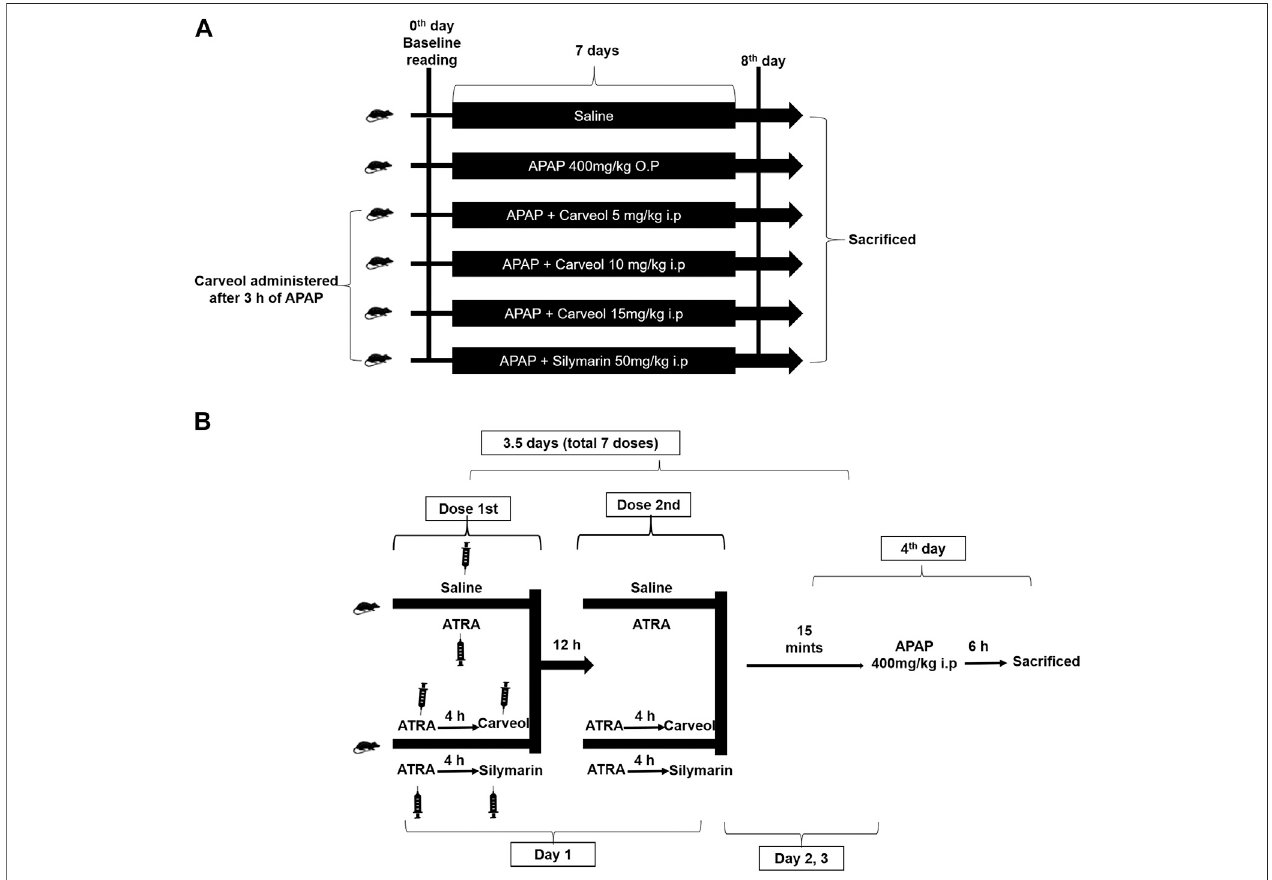
Figure 2 | Experimental design 1 (A) . Carveol, APAP, and silymarin were prepared in 0.9% NaCl, while ATRA was prepared in a mixture of 2% dimethyl sulfoxide and 0.9%NaCl( n (cid:1) 10/group).Baselinereadingwasrecordedatthebeginning (0thdayoftheexperiment), andmeanweight andfoodintakeweremonitored duringthe entire experiment (B) Diagrammatic illustration of in vivo study for the Nrf2 signaling pathway. The treatment protocol was continued for 3.5 days. In all these groups, a single loading dose of paracetamol was injected (400 mg/kg, i. p.) 15 min after the last dose of ATRA or carveol or silymarin, except in the saline group. Serum samples and liver tissues were collected after 6 h of the last